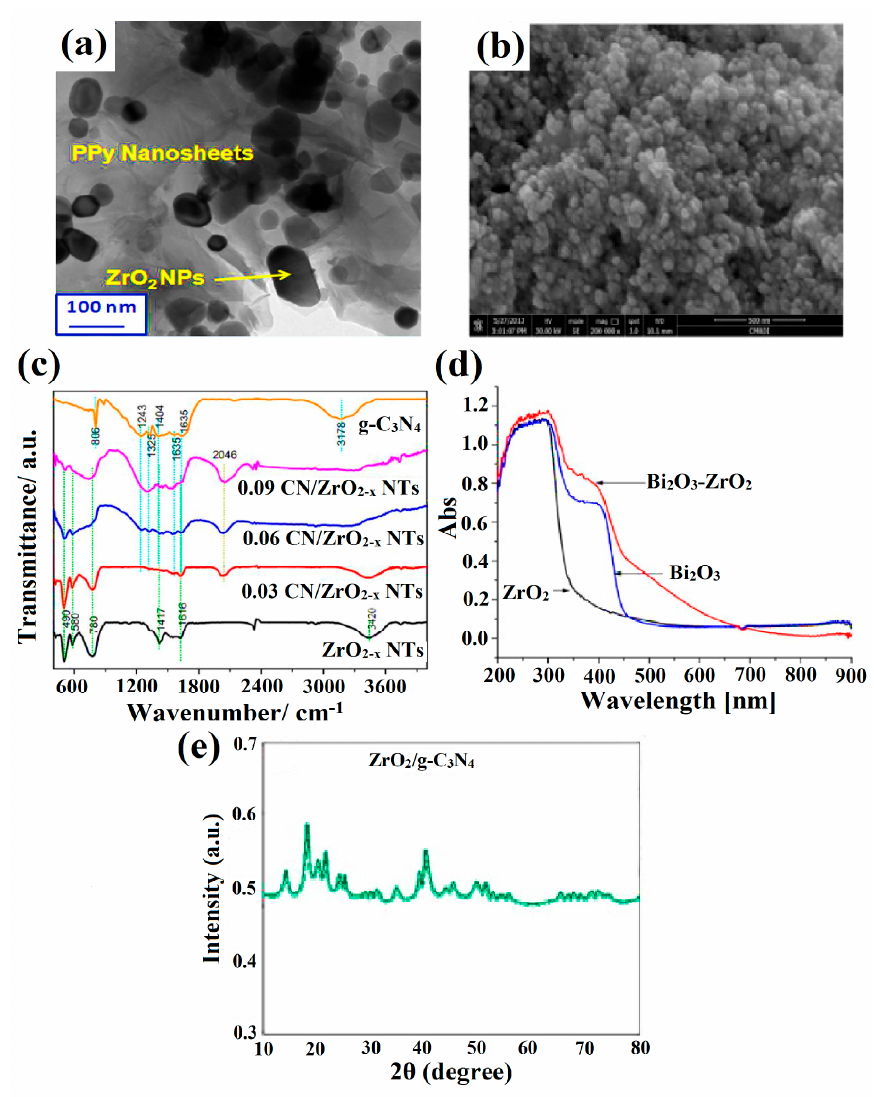
Figure 5. ( a ) HRTEM images and SAED pattern of ZrO 2 / PPy composite, reproduced with permission from Elsevier (License NO. 5333050908229) [53], ( b ) SEM images of calcined ZrO 2 -ZnCo 2 O 4 at 650 ◦ C, reprinted with permission from Elsevier (License NO. 5333051169811) [61], ( c ) FTIR spectrum of g-C 3 N 4 , ZrO 2 NTs and g-C 3 N 4 /ZrO 2 − x NTs, reprinted with permission from Elsevier (License NO. 5332980412880) [55], ( d ) UV-vis-DRS spectrum of Bi 2 O 3 -ZrO 2 , Bi 2 O 3 , and ZrO 2 , reproduced with permission from Elsevier (License NO. 5333060789631) [64], and ( e ) XRD pattern of 30 wt% ZrO 2 /g-C 3 N 4 [65].